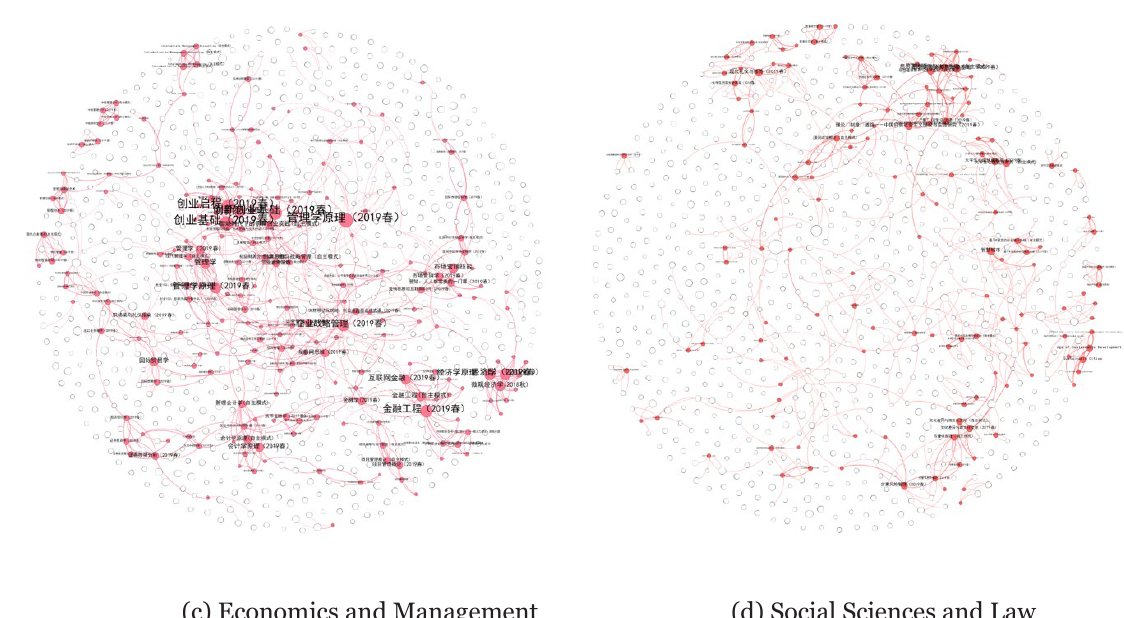
(c) Economics and Management (d) Social Sciences and Law Note. Red nodes represent the courses within the same disciplines, and white nodes represent the courses from other